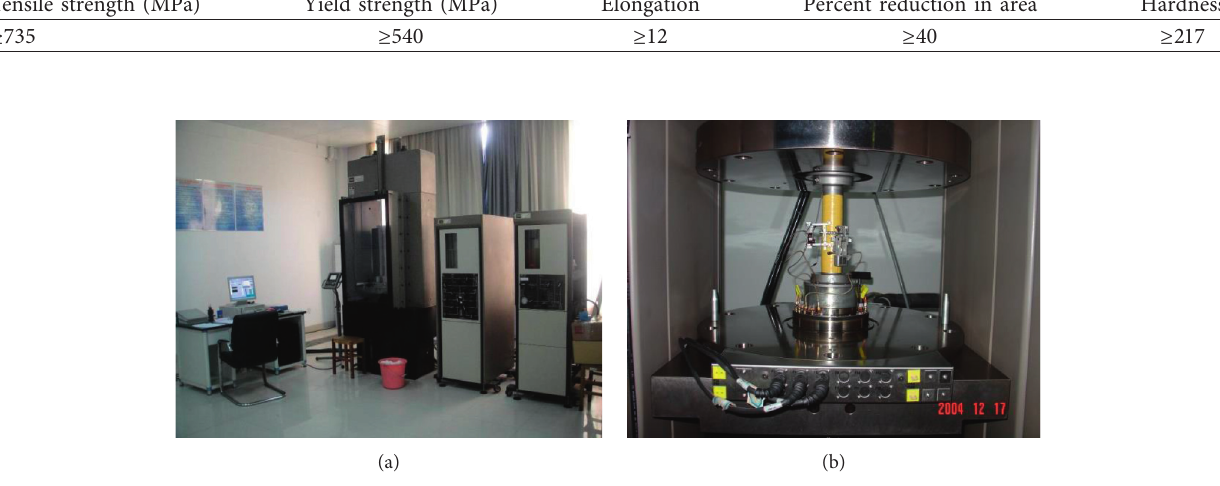
Figure 3: (a) MTS815.03 servo-controlled test system. (b) Specimen and sensors.